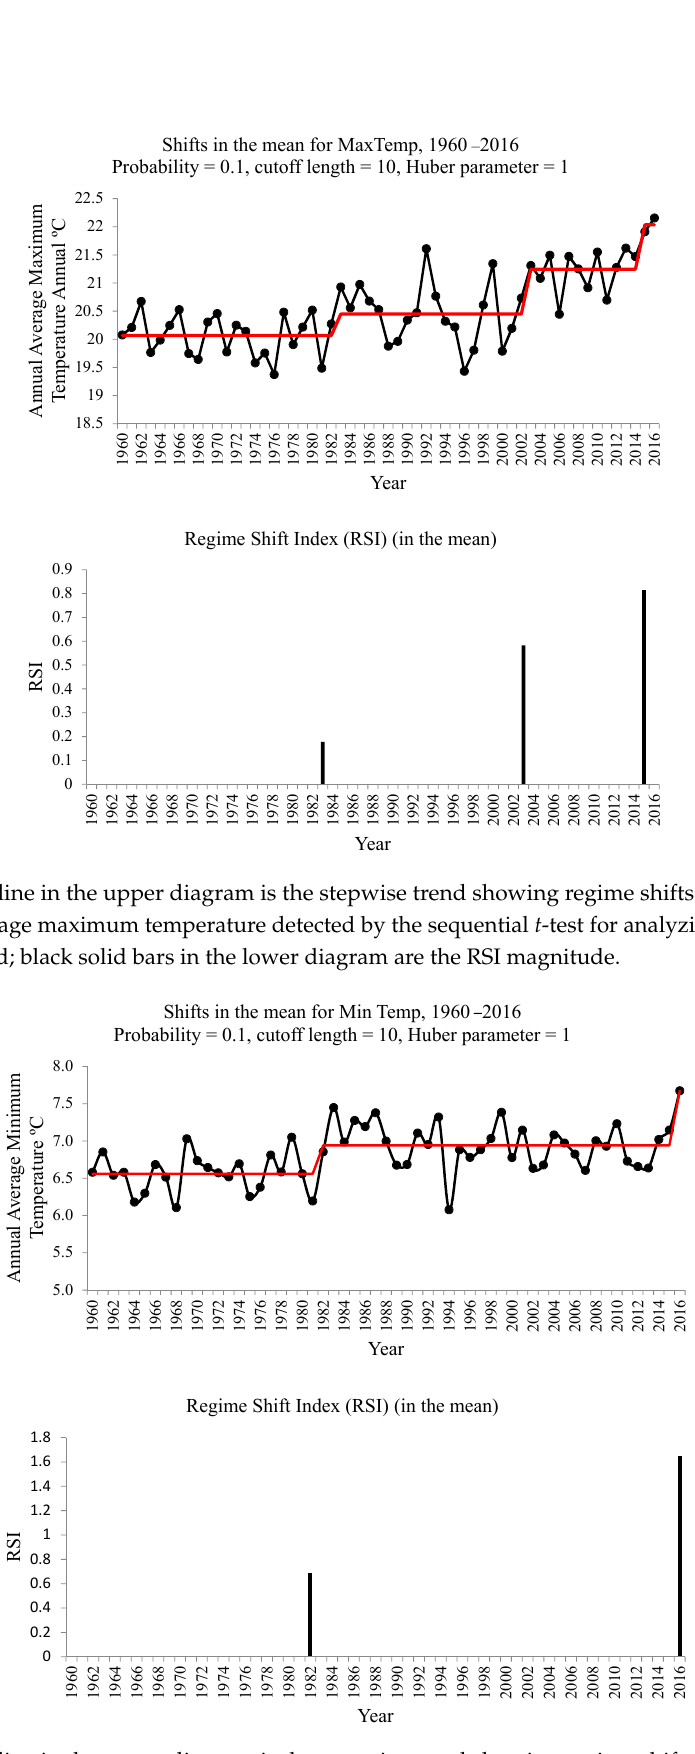
Figure 11. Red line in the upper diagram is the stepwise trend showing regime shifts in the mean of the annual average minimum temperature detected by the STARS method; black solid bars in the lower diagram are the RSI magnitude.